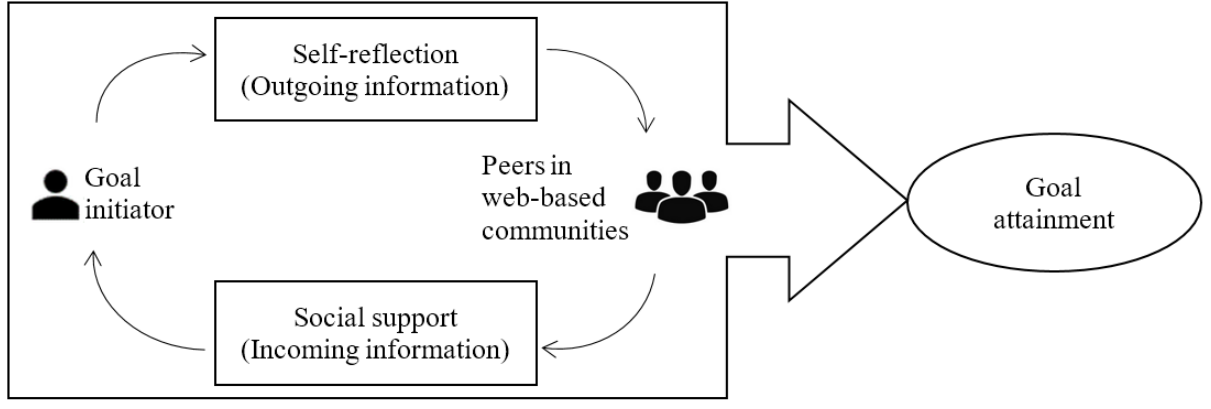
Social Support and Goal